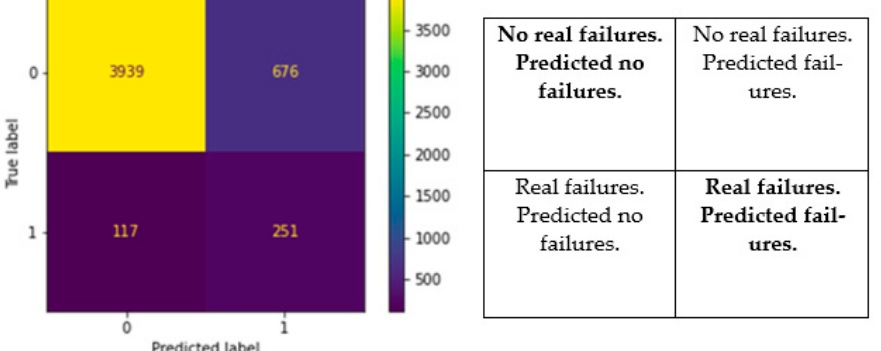
Figure 4. RF confusion matrix for the BA model.